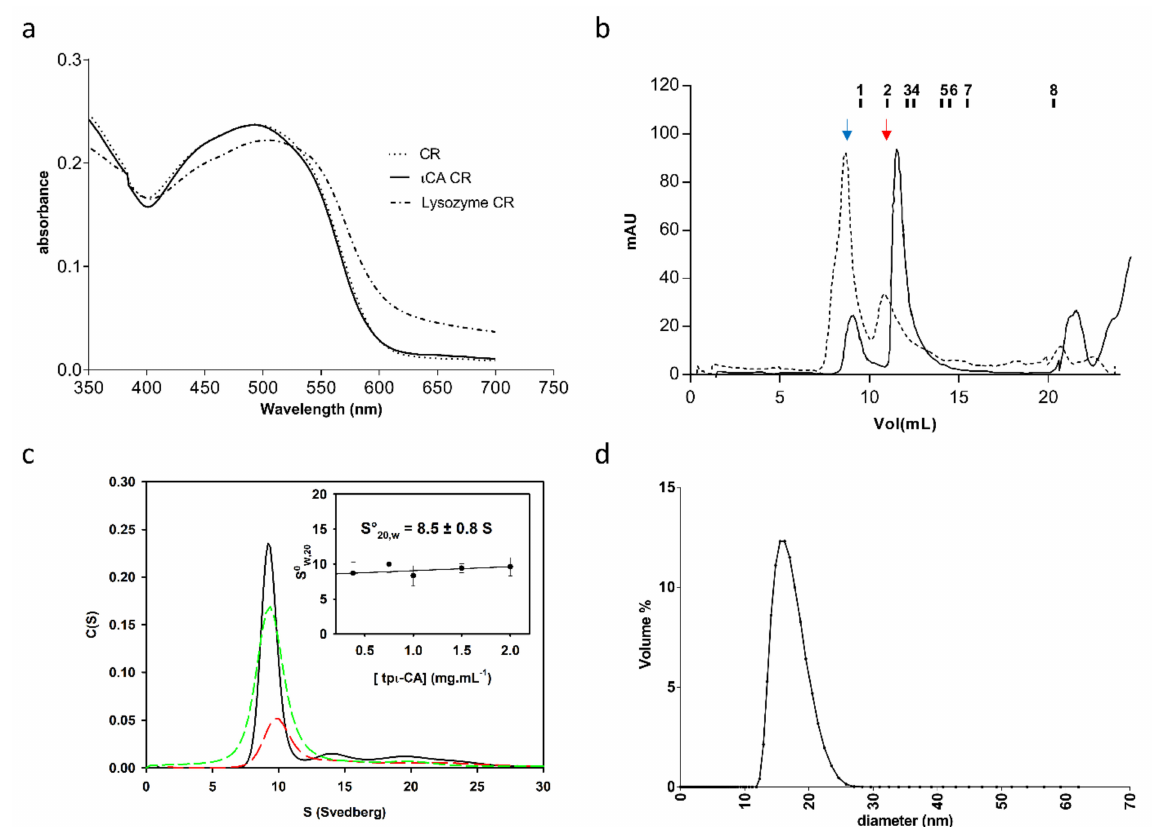
Figure 1. Oligomerization state of the tp ι -CA. ( a ) Congo red (CR) spectral shift assay from purified tp ι -CA. The spectrum of CR alone and mixed with a tp ι -CA sample is shown. The presence of fibrils is shown by a shift in the spectrum of a CR-lysozyme control previously heated at 55 ◦ C for 5 min prior to assay. ( b ) Size exclusion chromatography of recombinant tp ι -CA. The HMW form (dotted line) produces the LMM form (plain line) upon treatment with Benzonase. The elution volume of the LMM form is 10.71 mL which corresponds to an apparent MW of 280 kDa. The elution volumes of standard proteins are indicated above the profile: 1—blue dextran, 2—ferritin (440 kDa), 3—catalase (240 kDa), 4—aldolase (158 kDa), 5—Bovine Serum Albumin (BSA) dimer (136 kDa), 6—BSA monomer (68 kDa), 7—ovalbumin (43 kDa) and 8—Cytochrome C (12.5 kDa). Blue and red arrows show peaks corresponding to the HMM and LMM, respectively. ( c ) Sedimentation velocity experiment in an analytical ultracentrifugation (AUC) performed on the purified LMM form at different concentrations: 2.0 (black), 1.5 (green dashed) and 0.7 (red dashed) mg mL − 1 . Standard sedimentation coefficient S 0 20,W determination is obtained by extrapolating the S 20,W value at protein concentration equal to zero, as shown in the inset. ( d ) Dynamic light scattering (DLS) curve of the LMM